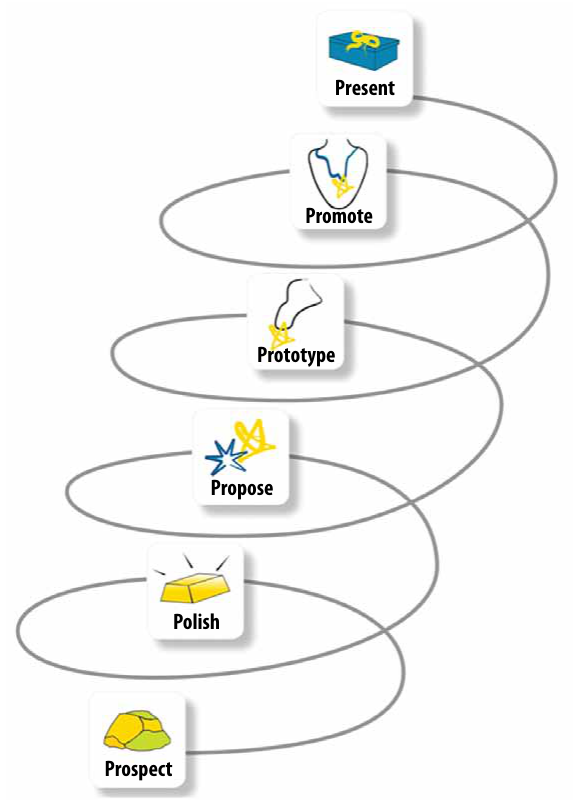
Fig. 6. The six steps along the path toward prosperity